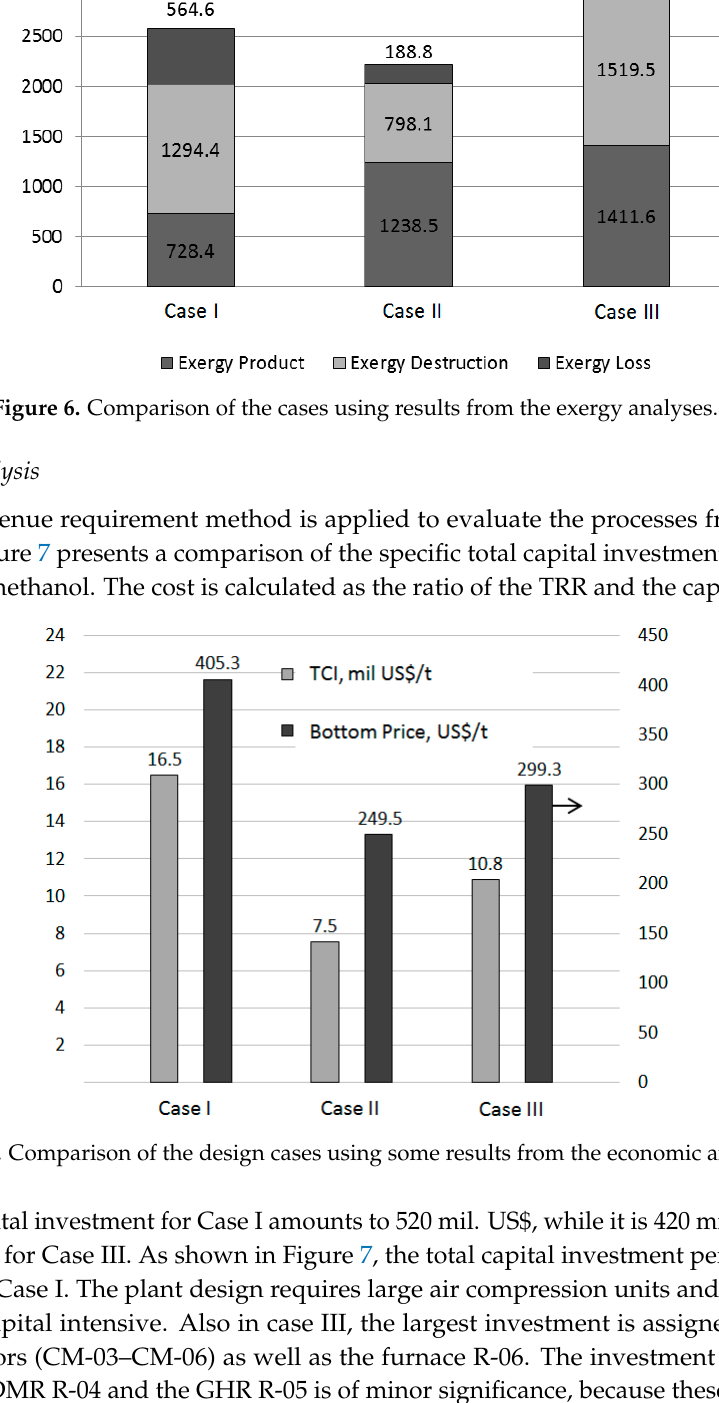
Table 6. Comparison of the cases using results from the exergoeconomic analyses.